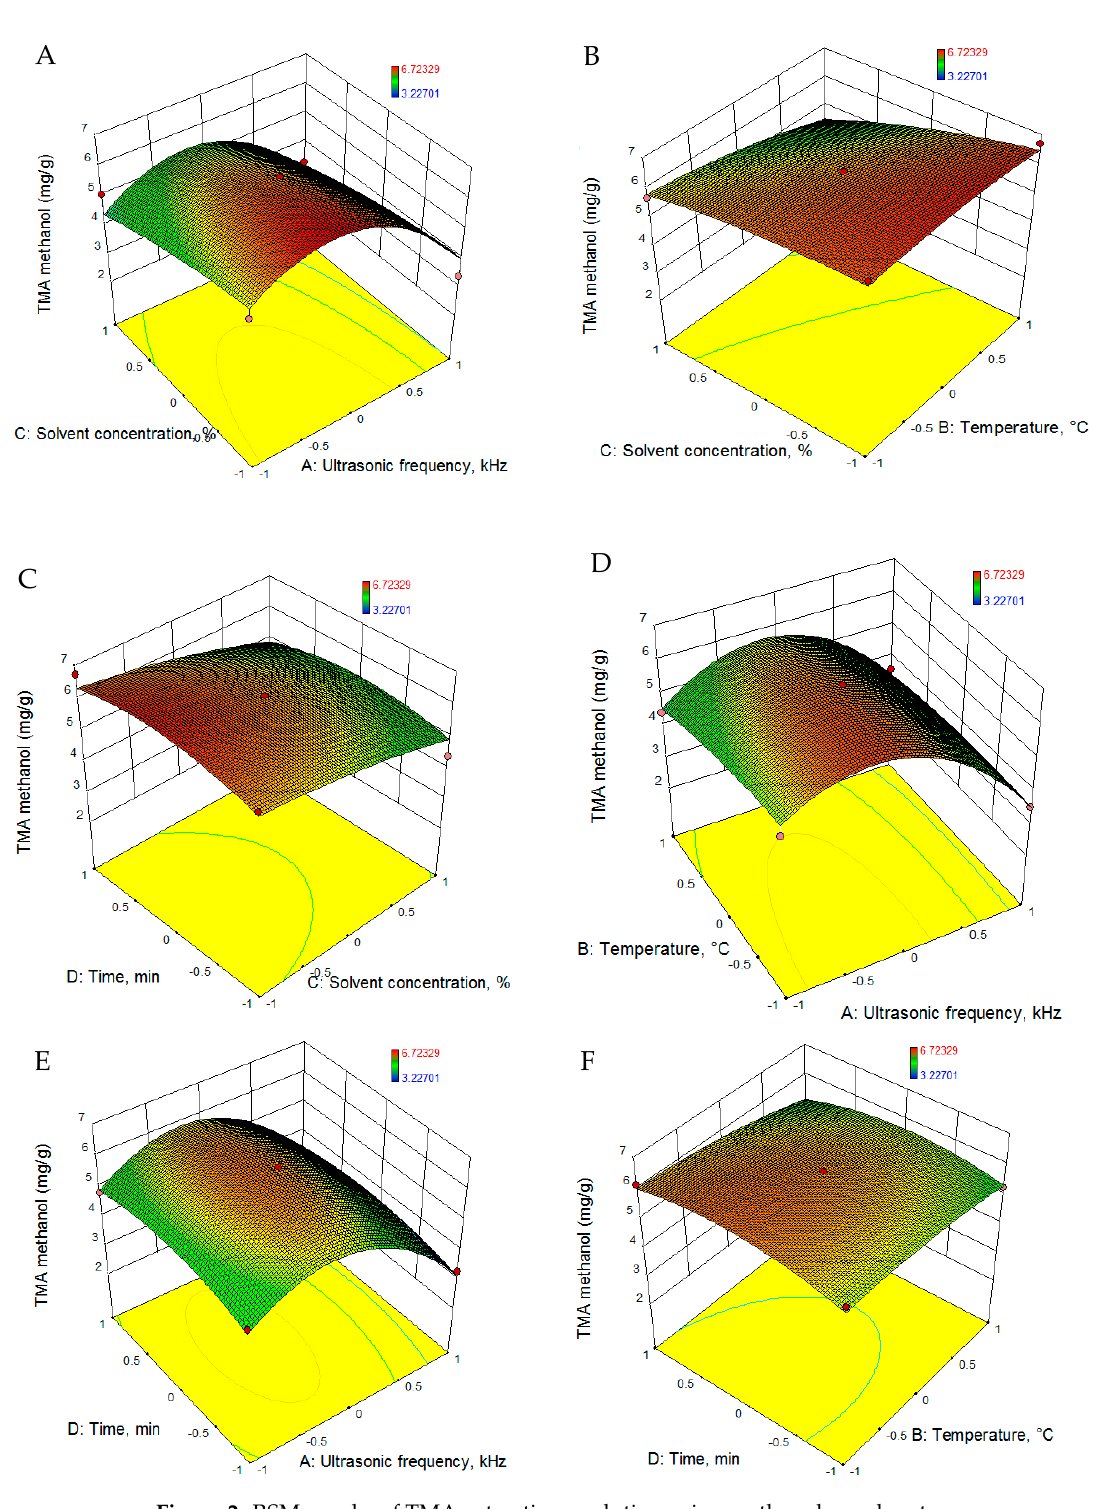
Figure 2. RSM graphs of TMA extraction evolution using methanol as solvent. Table 6. Parameters calculated after implementation of the Box–Behnken design.